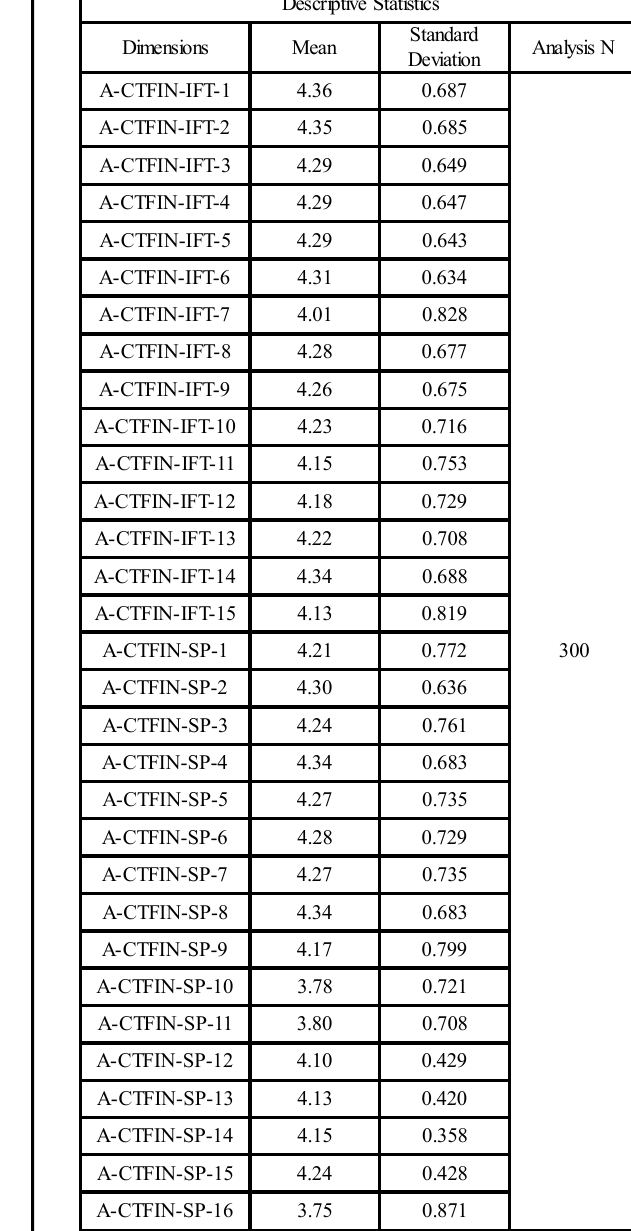
TABLE 5. DESCRIPTIVE STATISTICS DETAILS IN RELATION TO ANTI-COUNTERFEITING